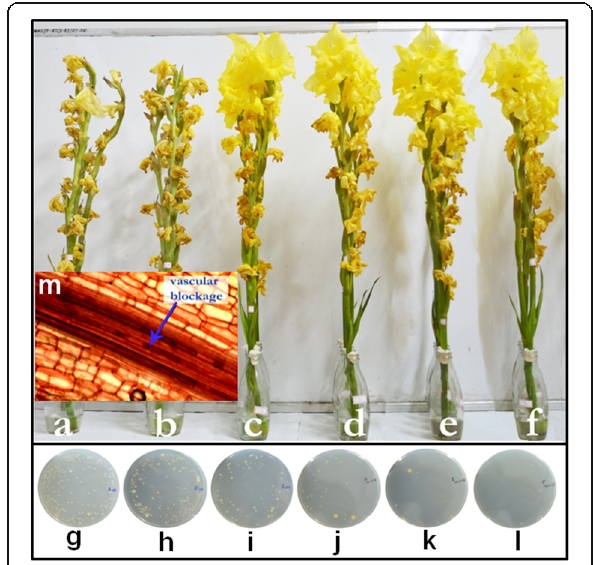
Fig. 4 Gladiolus spikes in different vase solutions at the 9th day of vase life. a Control, b T 1 , c T 2 , d T 3 , e T 4 , and f T 5 . Microbial colony development at the 7th day in different vase solutions (10 − 2 dilution) were cultured on LB agar plates and observed after overnight incubation at 37 °C. g Control, h T 1 , i T 2 , j T 3 , k T 4 , and l T 5 . m Vascular blockage in vessel observed after the 7th day by longitudinal sections (LS) of the gladiolus stems treated in T